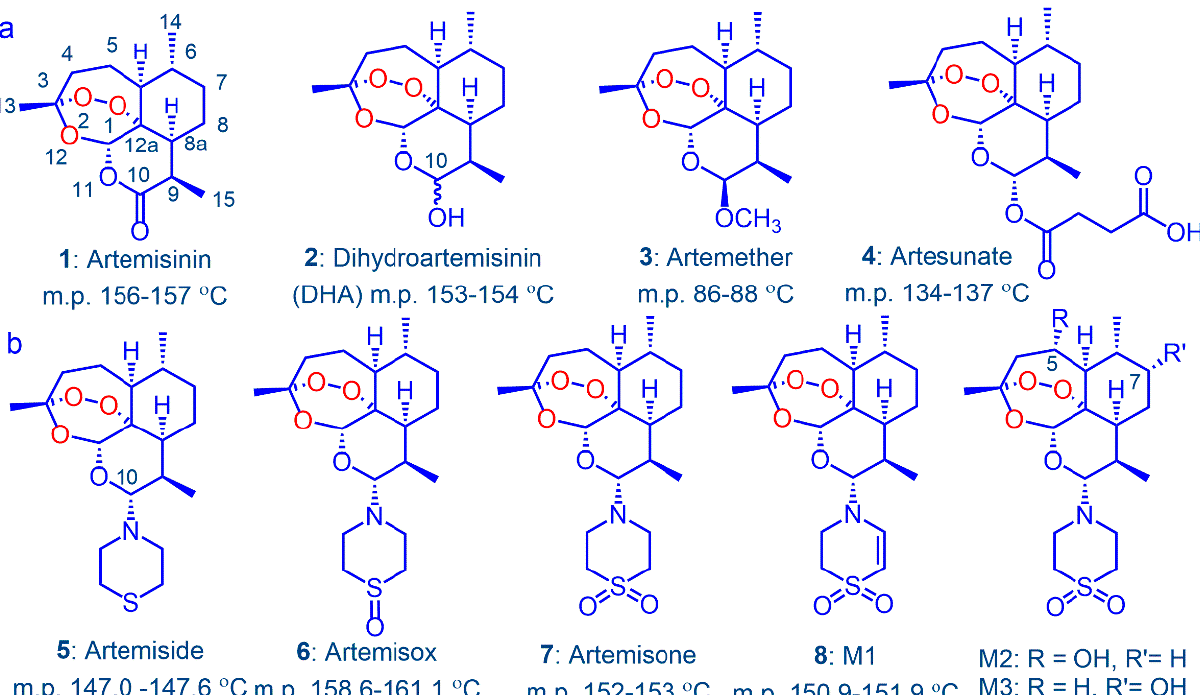
Figure 1. ( a ) Artemisinin 1 and clinical derivatives DHA 2 , artemether 3 and artesunate 4 [9–13]; the last two are rapidly converted into DHA in vivo [14–20]; ( b ) the highly crystalline thiomorpholine derivative artemiside 5 , the thiomorpholine S -oxide artemisox 6 , the thiomorpholine S , S -dioxide artemisone 7 , and the principal metabolites of artemisone: the unsaturated thiomorpholine- S , S -dioxide (1,4-dihydrothiazine- S , S -dioxide) M1 8 , and the hydroxylated artemisone derivatives M2 and M3 [24].